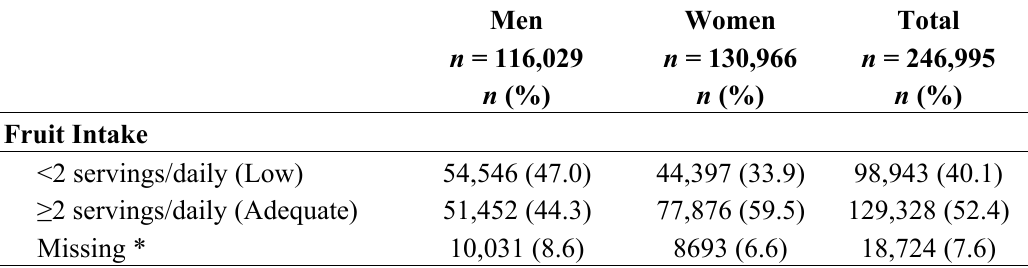
Table 2. Fruit and vegetable intake and Body Mass Index (BMI), by